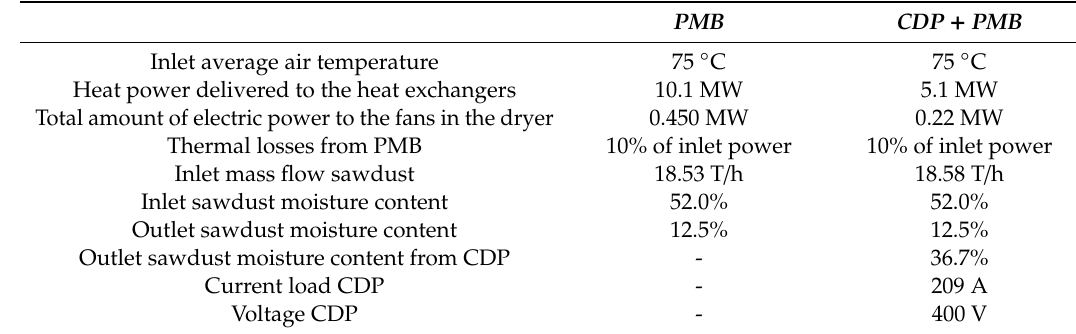
Table 1. Inlet data for the PMB and the CDP +